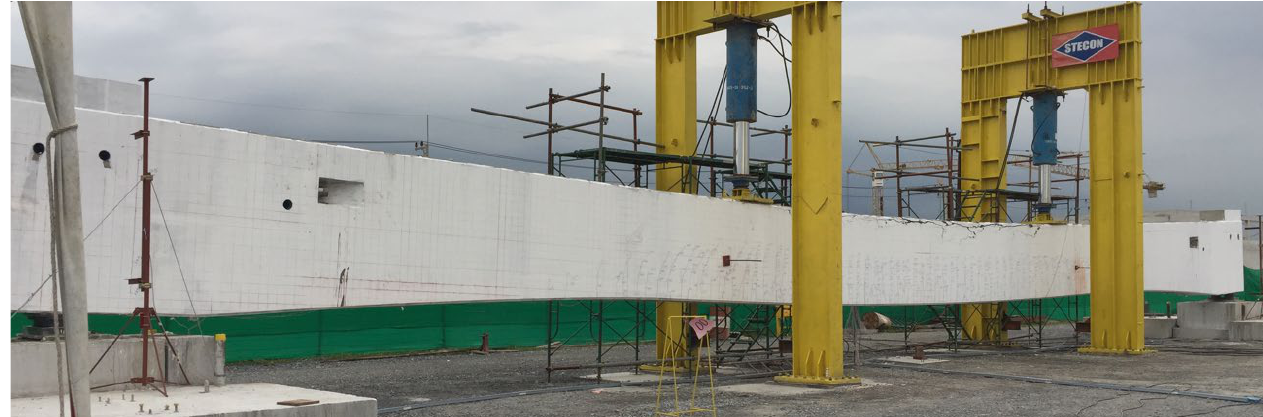
Figure 50. Ultimate failure of specimen SP-1, ( a ) line diagram, ( b ) concrete crushing.